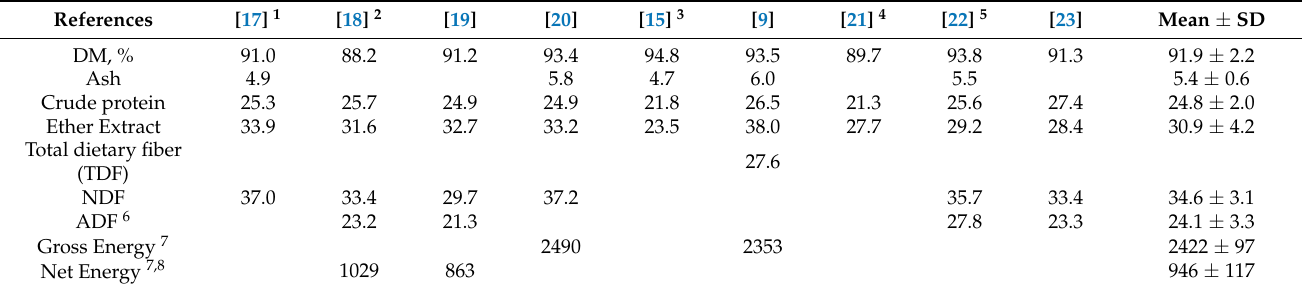
Table 1. Chemical composition (% on DM basis) of full-fat